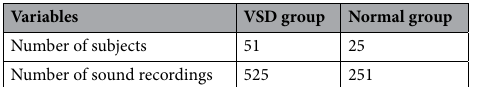
Table 3. Number of subjects and heart sound recordings in this